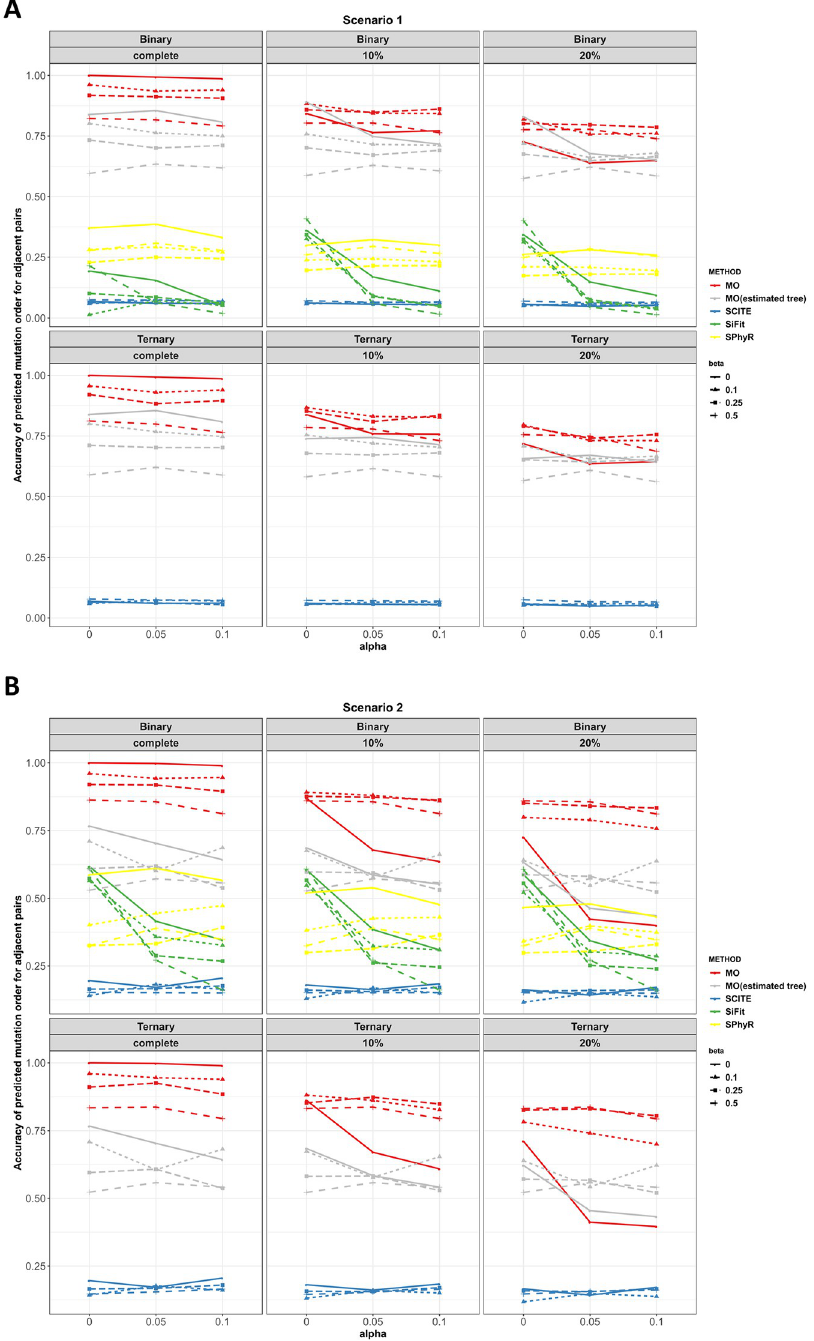
Fig 3. Adjacent order accuracy in scenarios 1 and 2 for MO, SCITE, SiFit and SPhyR when there are 20 mutations. Each panel includes the results from the specific type of genotype and missing data percentage. In each panel, red, gray, blue, green and yellow colors correspond to MO with the true tree, MO with the estimated tree, SCITE, SiFit and SPhyR, respectively. Each plotting symbol on the line represents a different β . The x-axis is the probability of a false positive error, α , and the y-axis is order